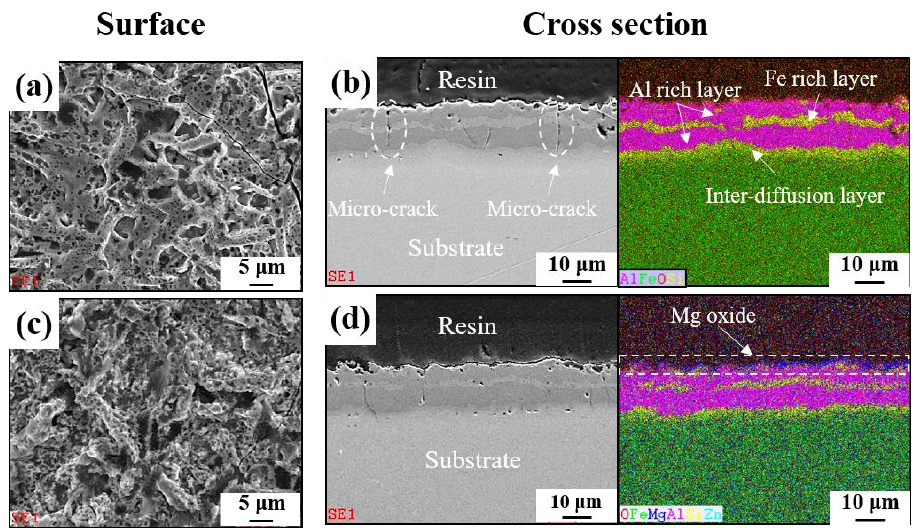
Figure 1. Surface and cross-sectional observations with eds mappings of ( a , b ) AlSi-MC and ( c , d ) AlSiZnMg-MC.